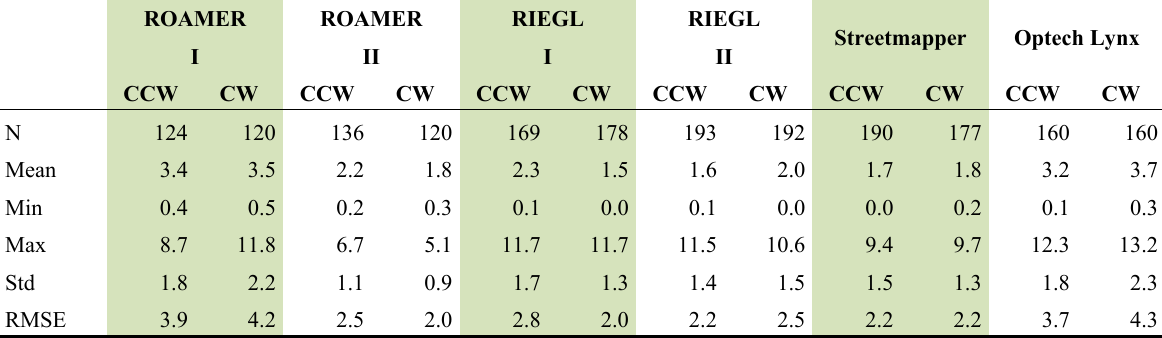
Table 4. The planimetric accuracy values, in cm, for the tested MLS systems. Driving directions: counter-clockwise CCW and clockwise CW. N is the number of used reference